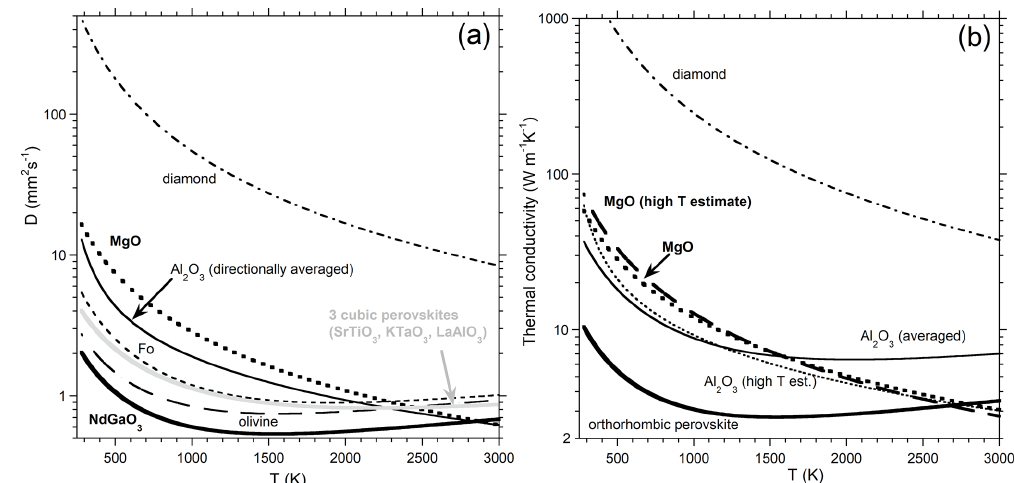
Figure 3. Heat transport properties of selected dense solids with a logarithmic y scale. (a) Thermal diffusivity on single crystals from laser-flash analysis, measured up to ∼ 1800K. Fits using three parameters are shown. Diamond from Hofmeister et al. (2014). Oxides from Hofmeister (2012). Forsterite and olivine are 001 plates (Pertermann and Hofmeister, 2006). Perovskites from Hofmeister (2010a). (b) Thermal conductivity calculated from data on D , c P , and density using Eq. (3). For the oxides, the dotted lines use constant, high- T values for c P and ρ , whereas their other curves use temperature-dependent data. Orthorhombic perovskite is an estimate for a wide range of compositions; see Sect.